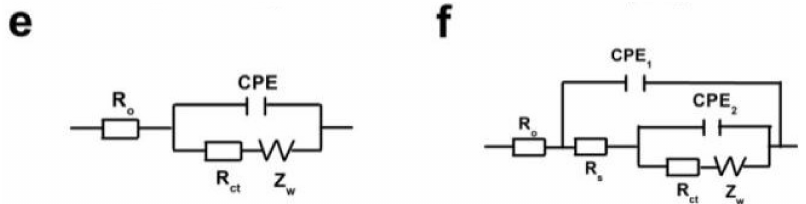
Figure 6. ( a ) CV curves of Li/S cells assembled with S/OMPW, ( b , c ) galvanostatic discharge/charge profiles and cycling test of S/OMPW at 0.1 C, ( d ) Nyquist plots of Li/S cells with S/OMPW, and ( e ) equivalent circuit of fresh Li/S cells and ( f ) cycled Li/S cells with S/OMPW.